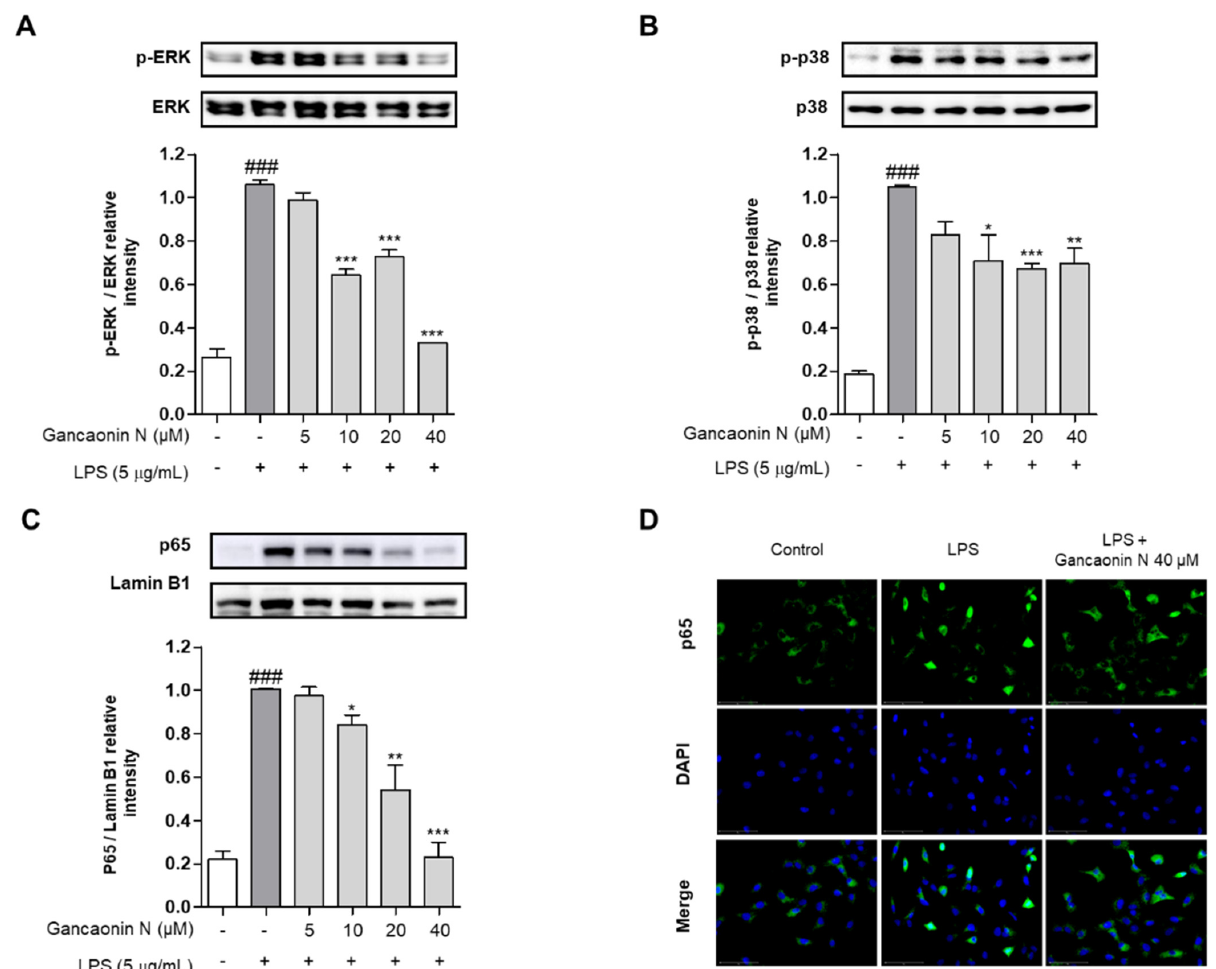
Figure 5. Effect of Gancaonin N on MAPK/NF- κ B signaling pathway in LPS-induced A549 cells. Gancaonin N (5–40 µ M) was pretreated 2 h prior to LPS-induced inflammation in A549 cells, incubated for 6 h with LPS (5 μ g/mL). The protein levels of ERK ( A ), p38 ( B ), and NF- κ B p65 ( C ) were investigated by immunoblotting assay. Ratio of each protein was determined by ImageJ. The expression of NF- κ B p65 ( D ) in the nucleus was confirmed using immunofluorescence assay (magnification: 400×, scale bar:75 μ m). Values are represented as means ± SEM. ### p < 0.001 is significantly different from non-treated group; * p < 0.05, ** p < 0.01, *** p < 0.001 are significantly different from only LPS-treated group.